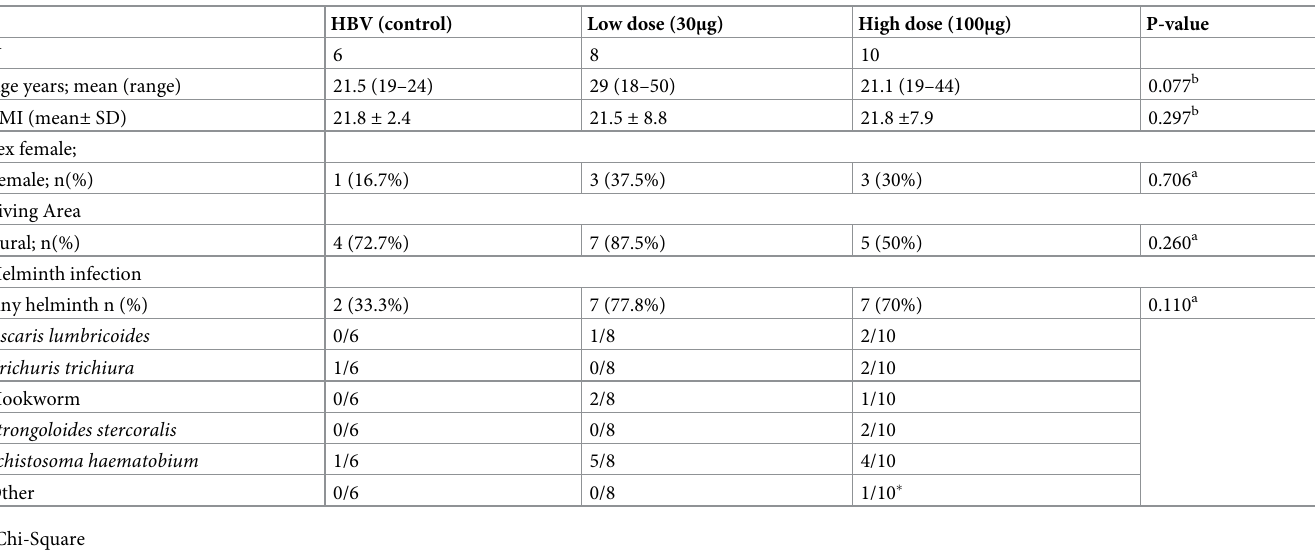
Table 1. Characteristics of study participants (N =